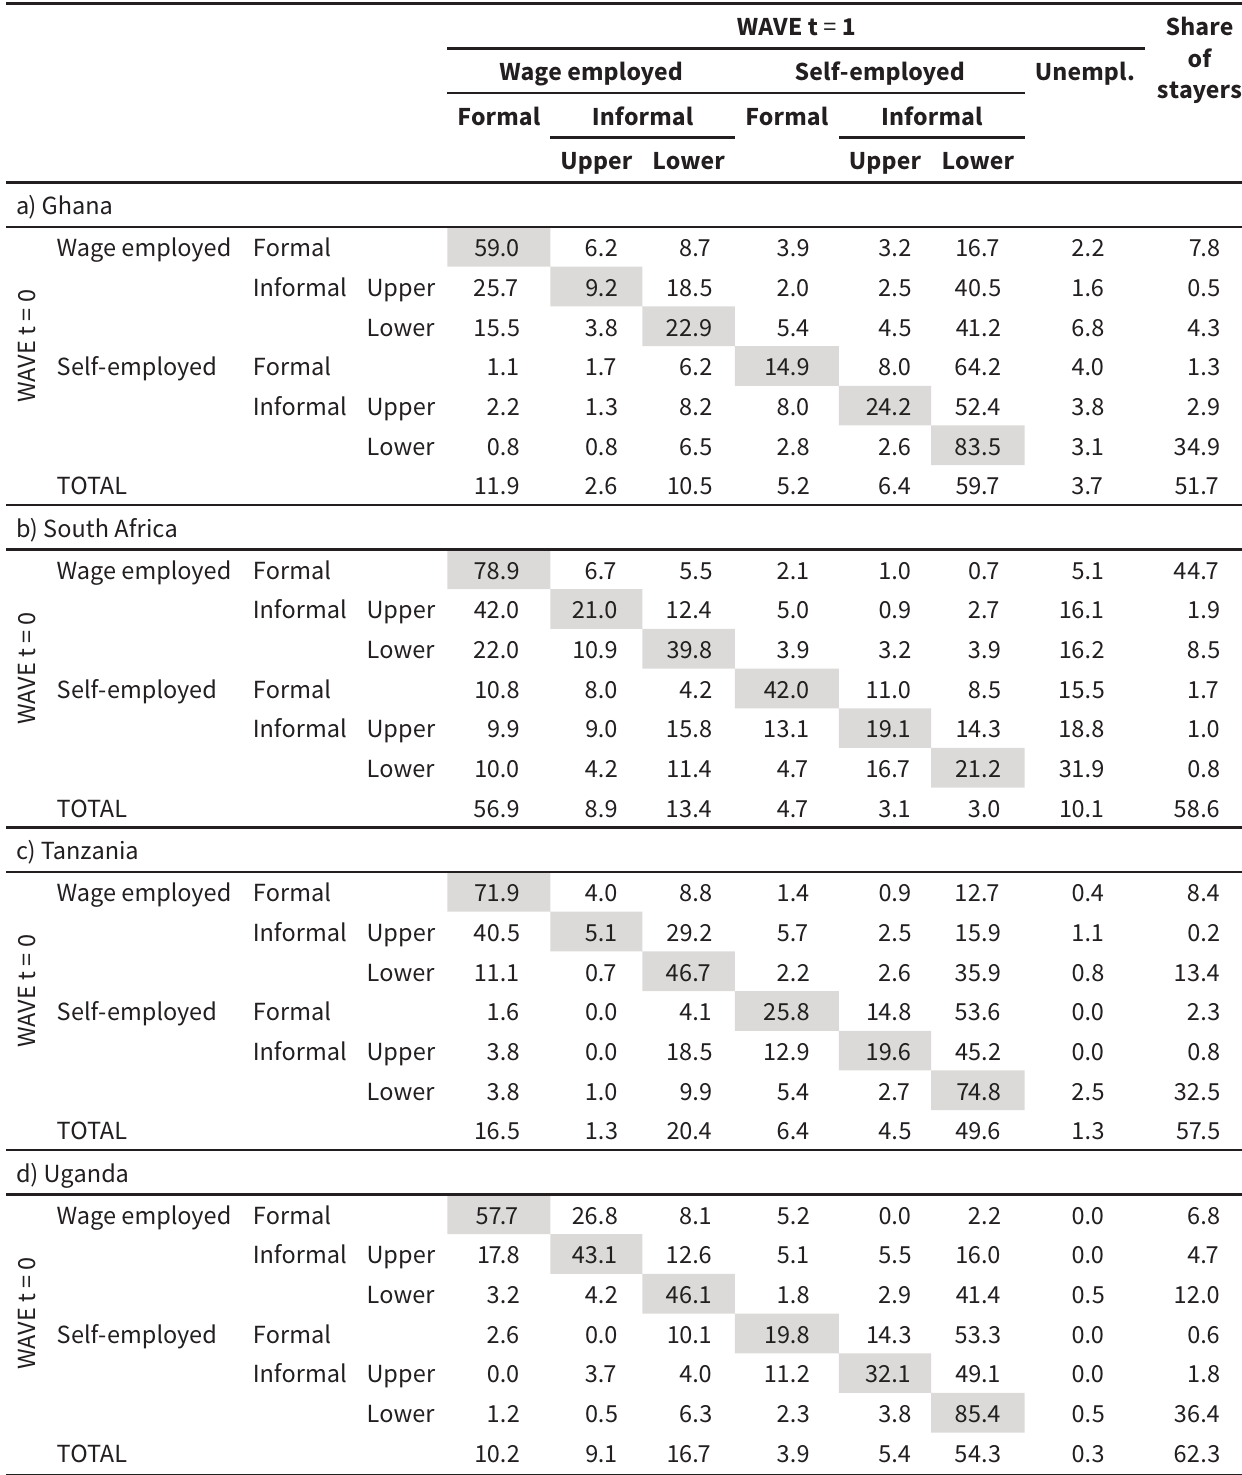
Table B5 Transition matrices across work status groups, including additional destination states (family farms under lower-tier informal self-employment and unemployment) WAVE t =